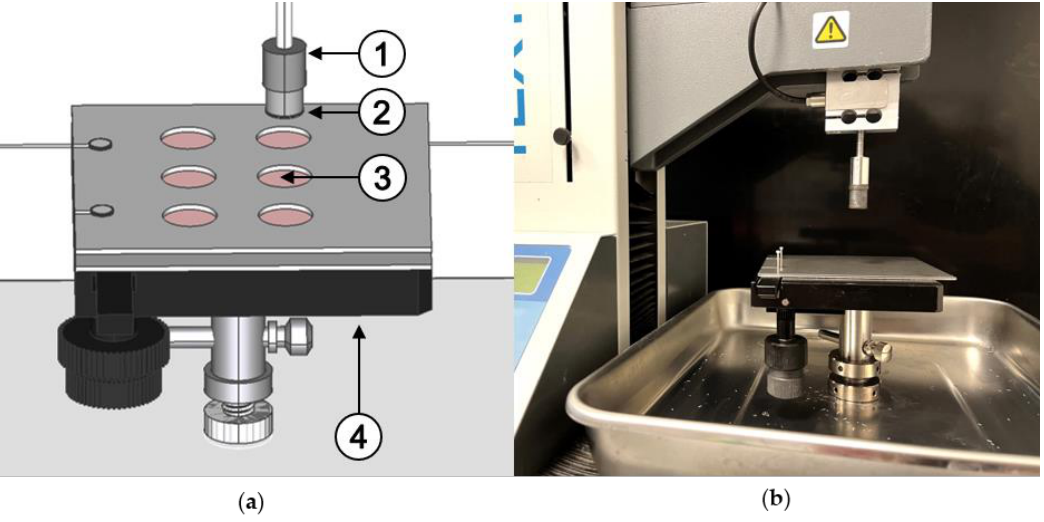
Figure 1. ( a ) Schematic illustration of the structural modifications made on the texture analyzer. 1: probe, 2: film sample, 3: porcine small intestine tissue and 4: microscope stage. ( b ) Photograph of